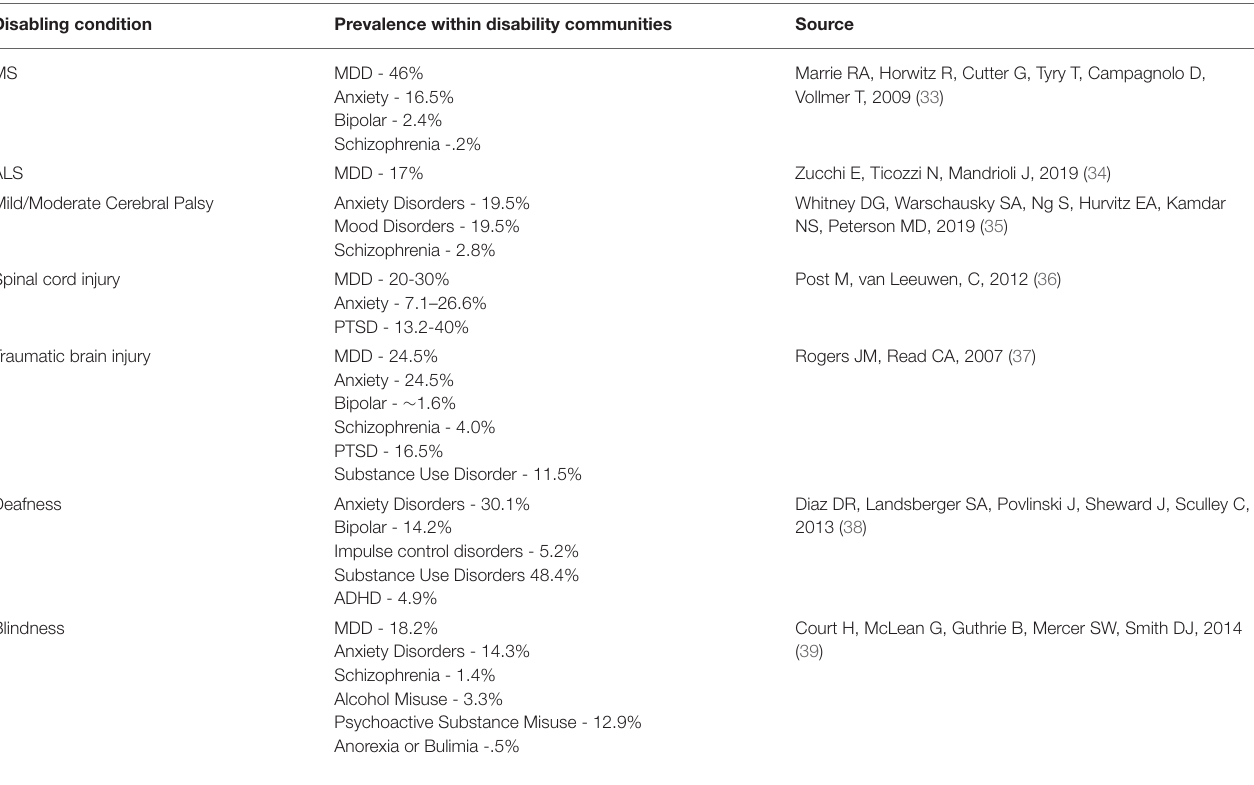
TABLE 2 | Disability community prevalence of mental